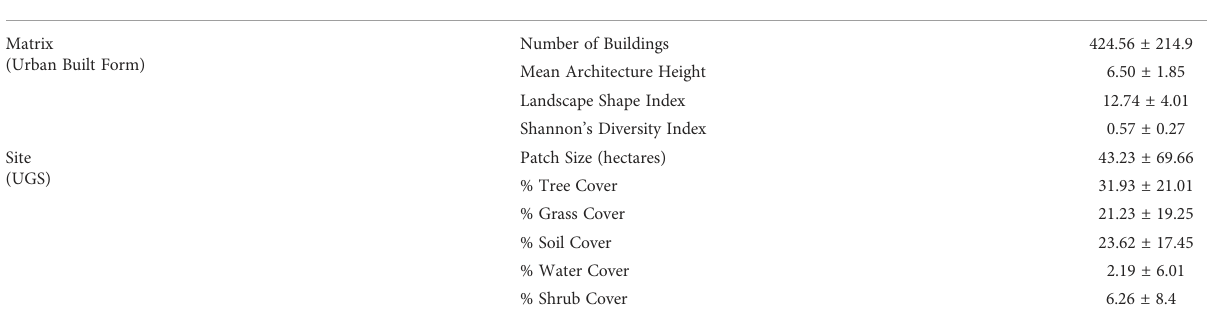
TABLE 1 The mean and standard deviation of each